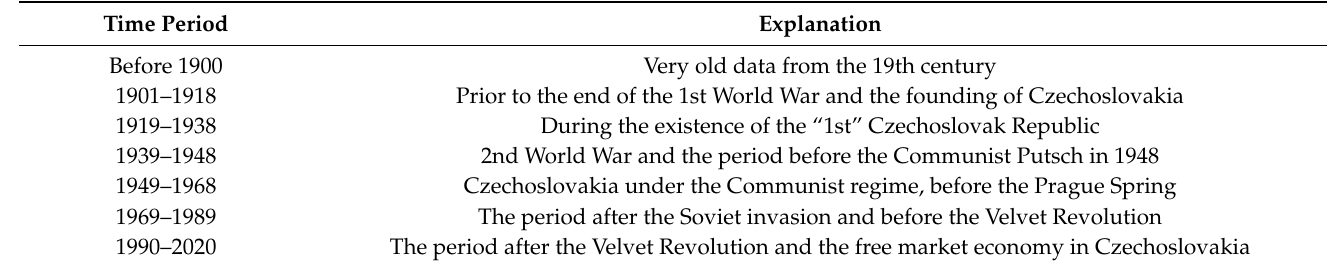
Table 1. Explanation of the selected time